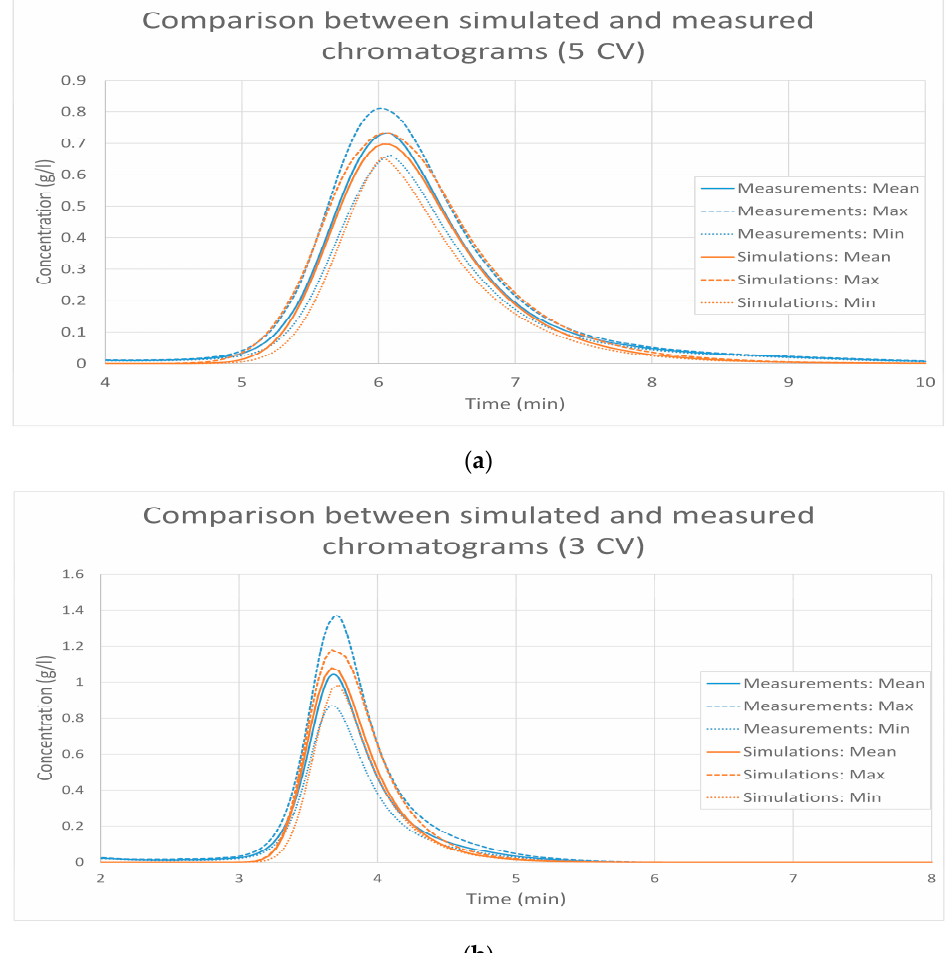
Figure 5. Comparison between simulated (orange) and measured (blue) chromatograms for a gradient steepness of 5 CV ( a ) and 3 CV ( b ). Solid lines represent mean, dashed lines represent maximum, and dotted lines represent minimum values.